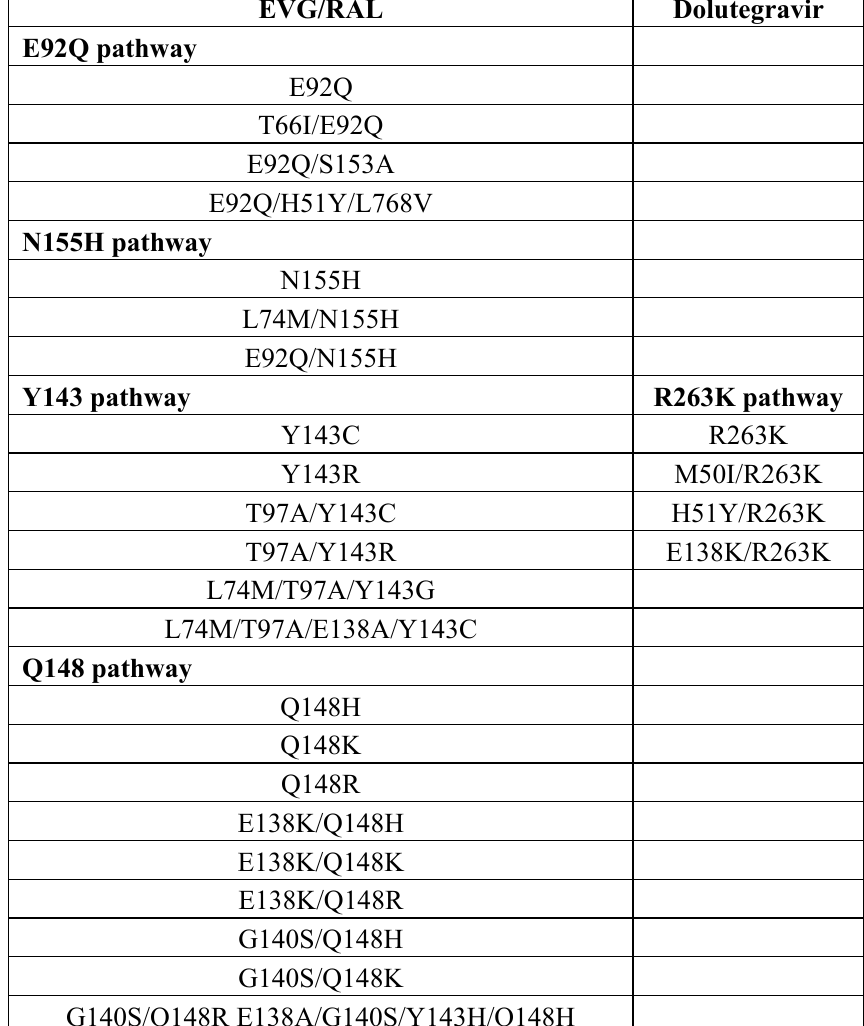
Table 1. Resistance pathways for each of dolutegravir (DTG), raltegravir (RAL), and elvitegravir